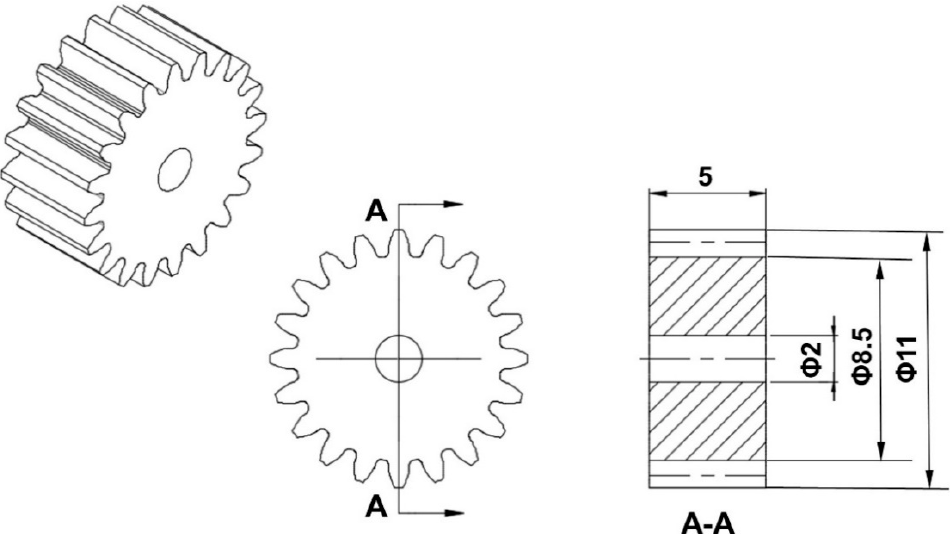
Figure 2. The 3D model and dimension parameters of the studied gear: Module (m) = 0.5 mm; number of teeth (z) = 20; modification coefficient ( χ ) = 0; pressure angle ( α ) = 20 ◦